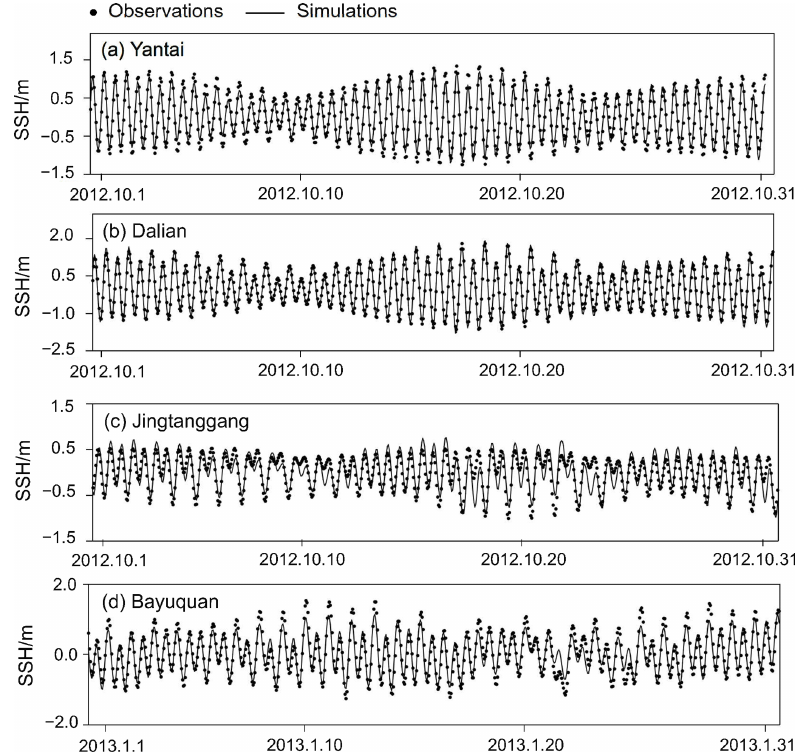
Figure 3. Comparison of sea surface height (SSH) between the observations and NEMO-Bohai simulations at (a) Yantai, (b) Dalian, (c) Jing- tanggang, and (d) Bayuquan stations in the Bohai Sea. Table 1. Key physical parameters in the ocean namelist (namelist_oce) in NEMO-Bohai.